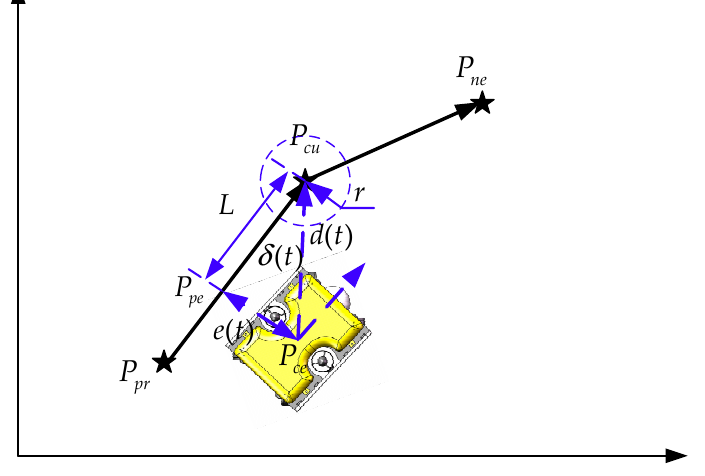
Figure 2. Cross-track position and heading angle errors for the AUV.